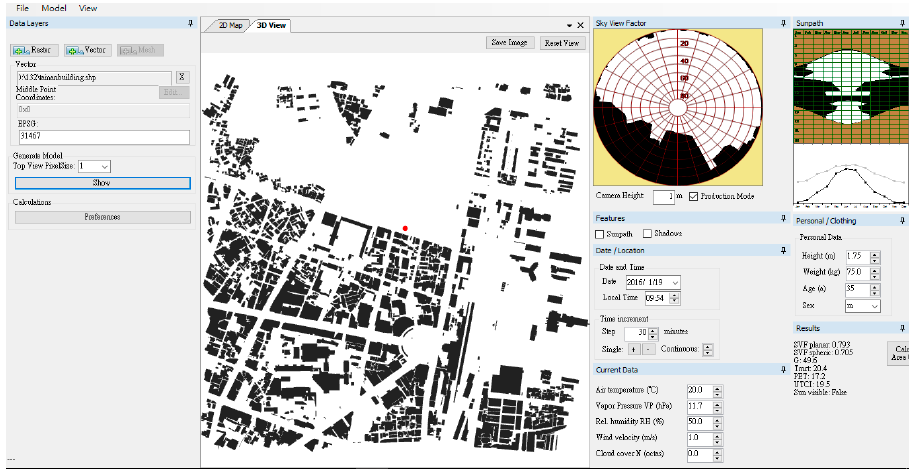
Figure 4. The graphical user interface of the urban climate model SkyHeilos.